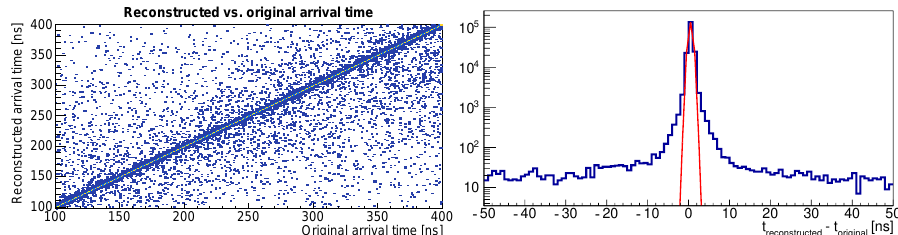
Figure 5. ( Left ) Reconstructed vs. original time of arrival for all events in the test set. ( Right ) Distribution of the signals according to the difference between the reconstructed and the original signal arrival time. The red curve represents a Gaussian distribution with σ ≈ 520 ps and mean value of 0.